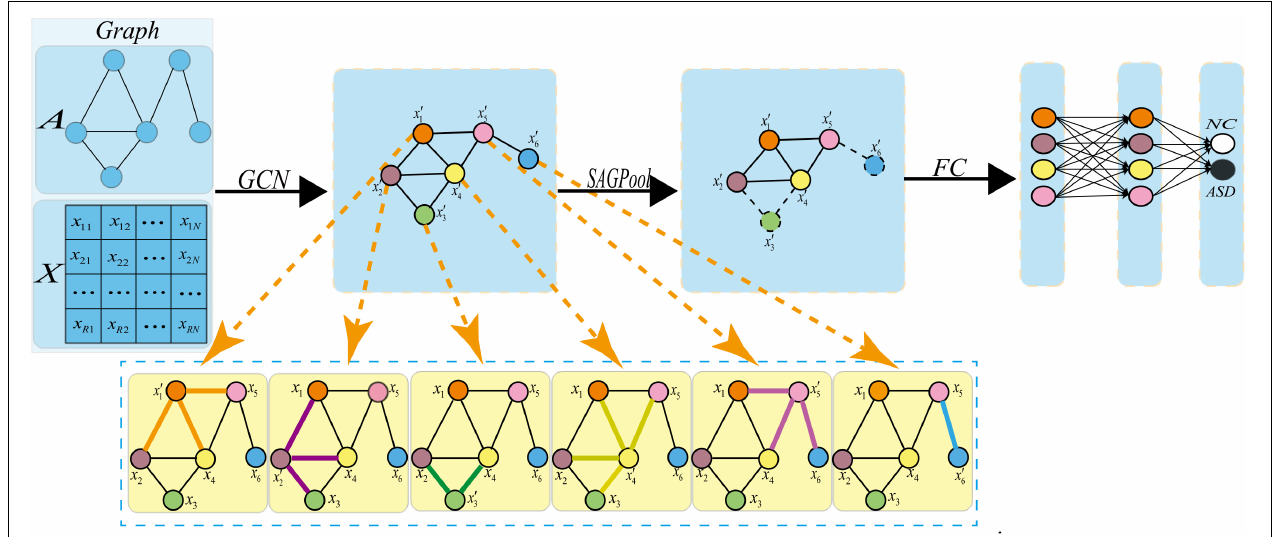
Frontiers in Human Neuroscience |